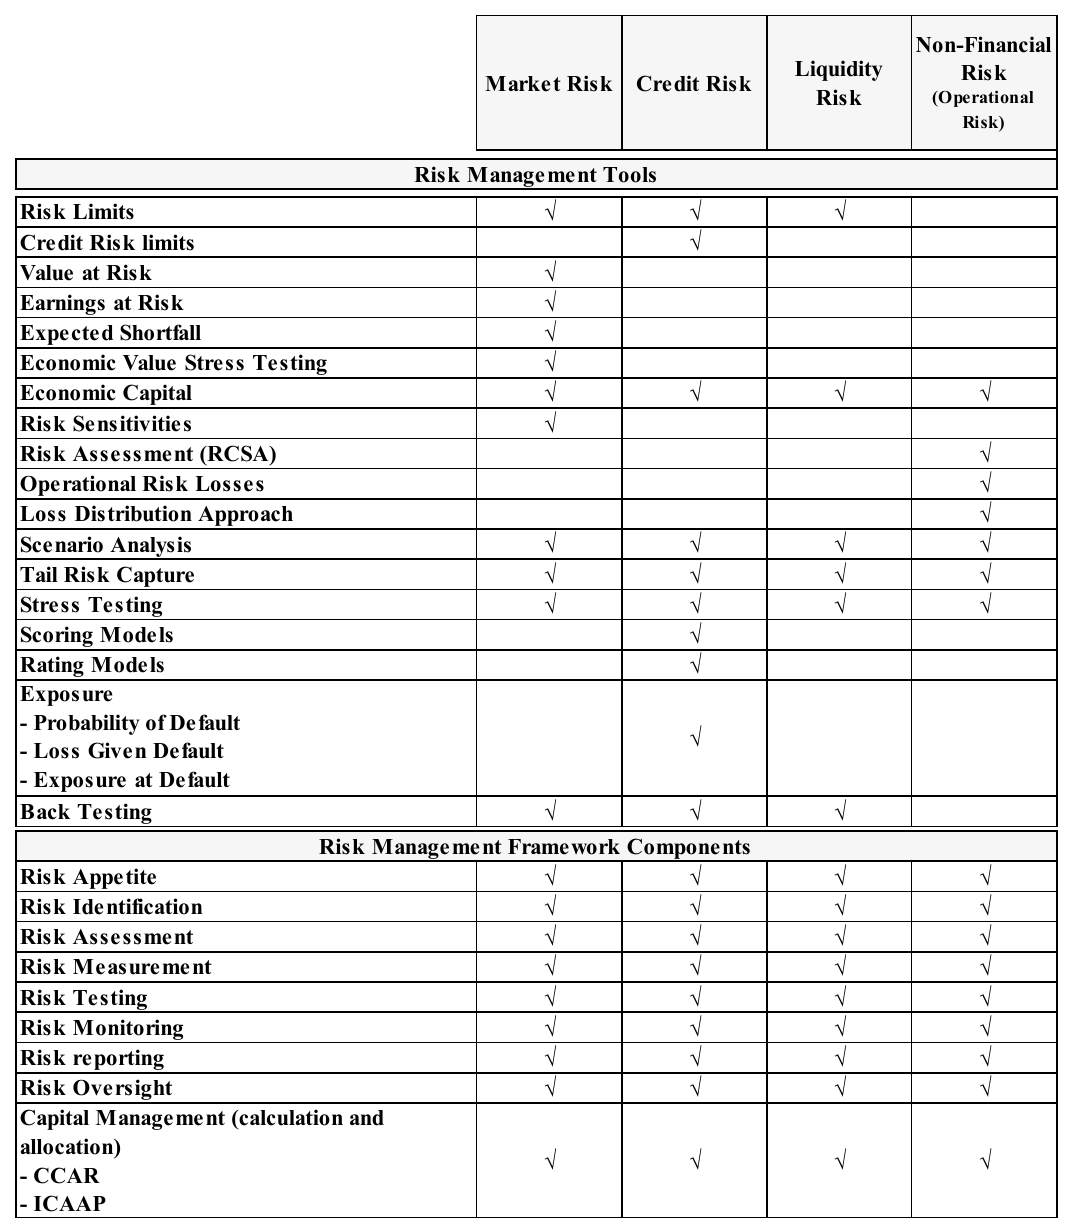
Figure 2. Risk Management Methods and Tools.